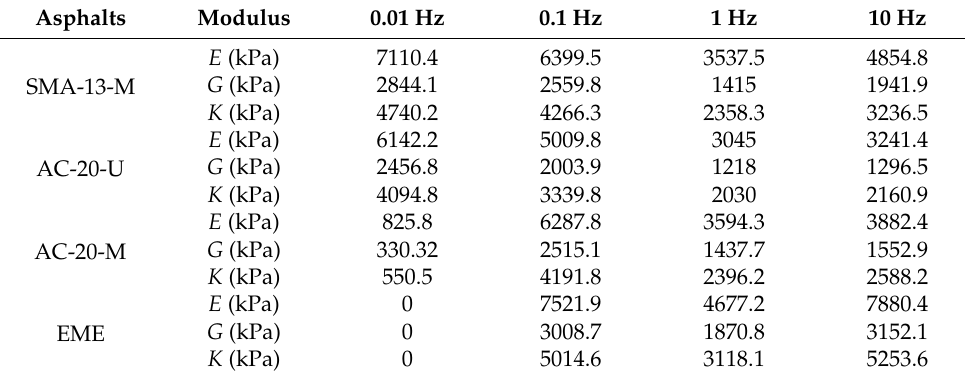
Table 3. Physical properties of the asphalt mixture.